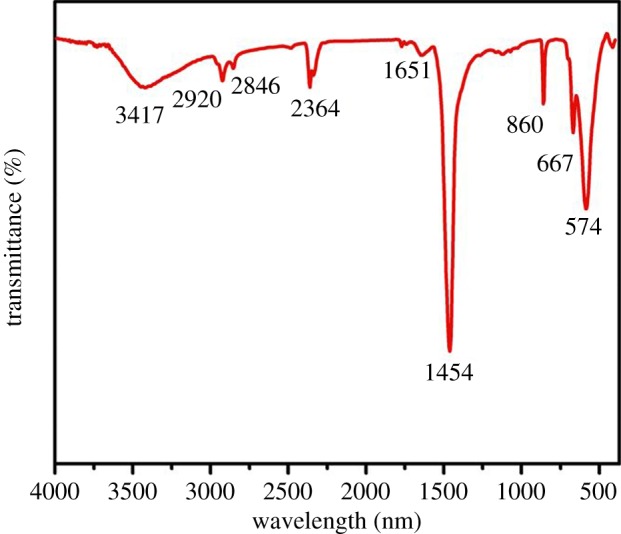
FT-IR spectra of the La0.6Sr0.4CoO3 perovskite catalyst.